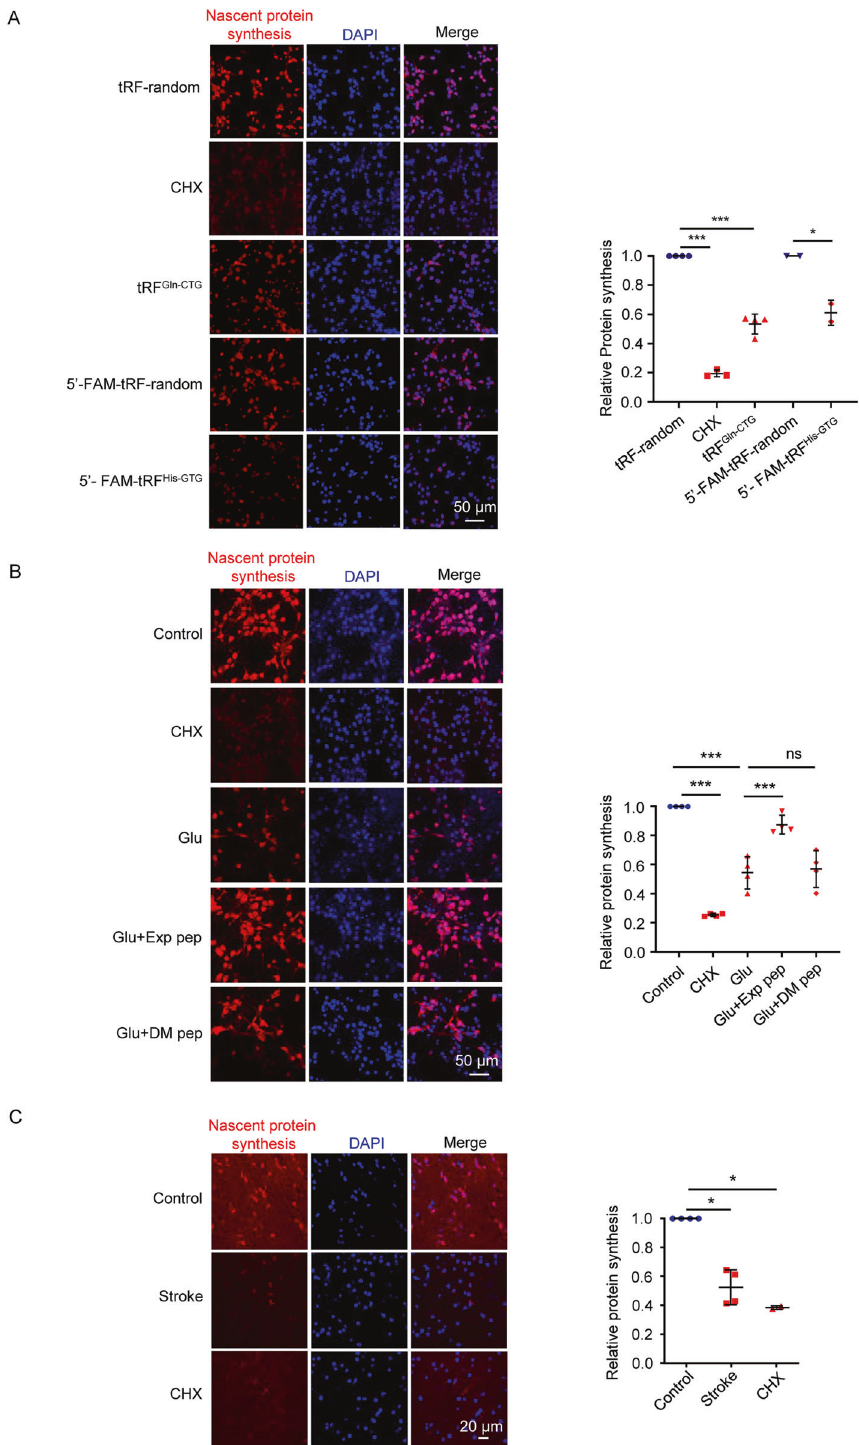
Fig. 3 Nascent protein synthesis during neuronal necrosis. A After transfection of tRFs for 1 h in primary neurons, the nascent protein synthesis was determined by a kit. Cycloheximide (CHX) is a well-known protein synthesis inhibitor with 10 μ M applied. For each treatment, fi ve fi elds were randomly selected. The averaged fl uorescent intensity of the control was set as 1, and the relative intensity of the experimental groups was determined and plotted (the same quanti fi cation method was used in ( B , C ). Trial n = 4. *** P < 0.001. B After glutamate treatment for 30 min, nascent protein synthesis was determined, with or without Exp pep or DM pep pretreatment. Trial n = 4. C Alive brain slices were obtained 1 h after an ischemic stroke model in mice. As a control, brain slices from the sham-operated mouse were obtained. The sham- operated mice were also treated with CHX for 1 h, which served as a positive control for the inhibition of protein synthesis. Then, the protein synthesis assay was performed in the brain slices. For the ischemia model and sham control, four mice were tested, respectively. Two mice were tested for the CHX